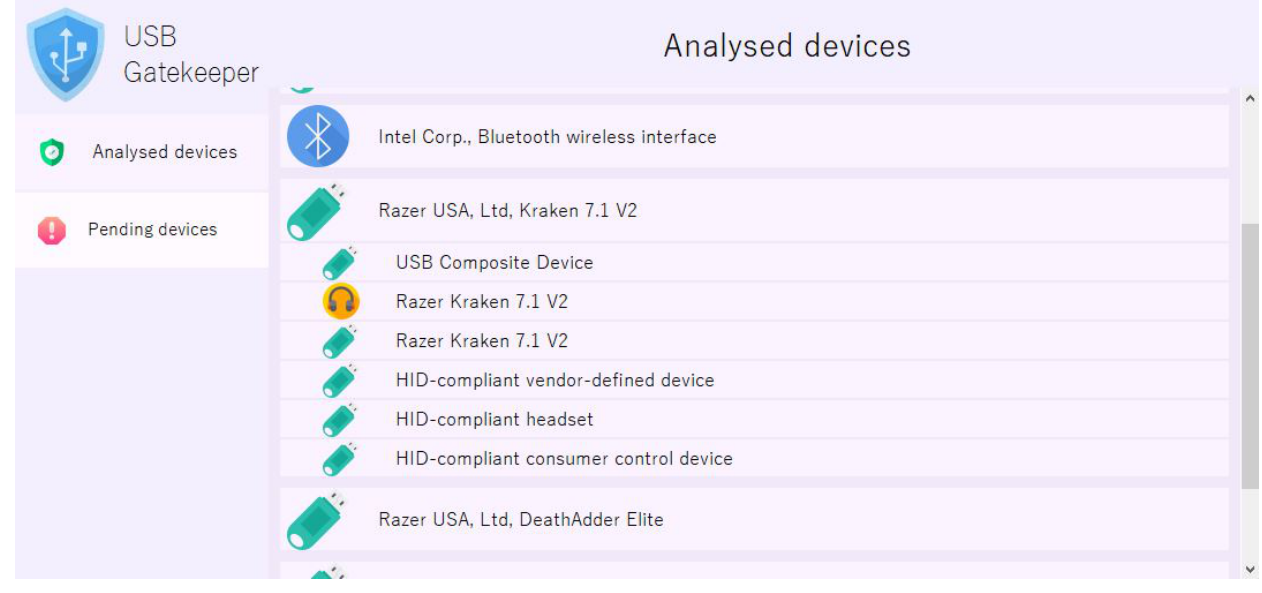
Figure 4. Main page with the list of analysed devices.